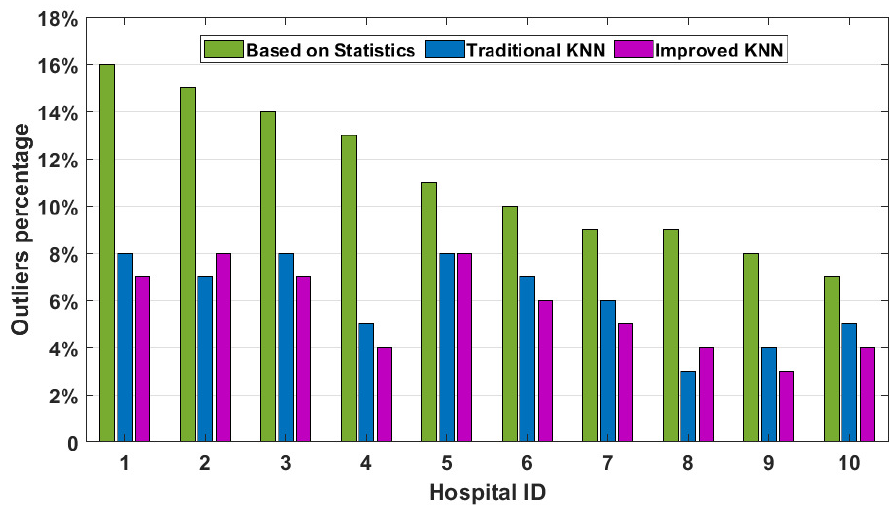
Figure 12. The proportion of abnormal points in disease A for the top-10